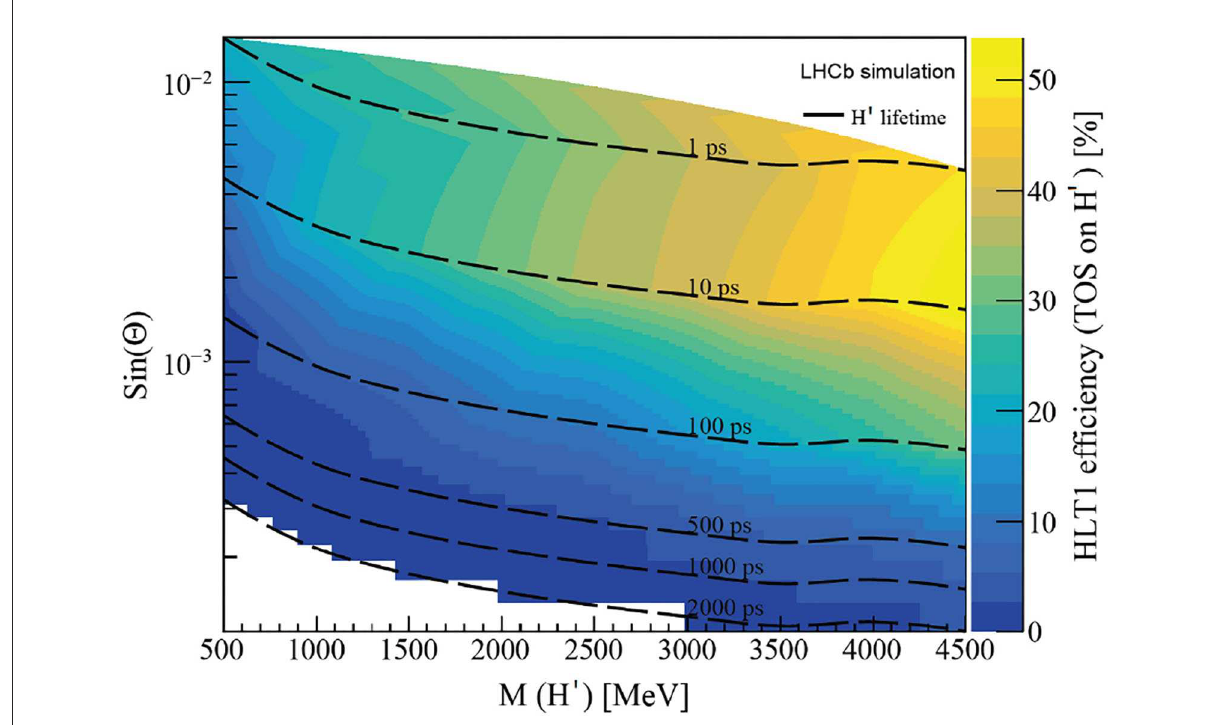
FIGURE10 Proportion of events triggered by the HLT1 decision on the H’ decay products (Trigger on Signal,